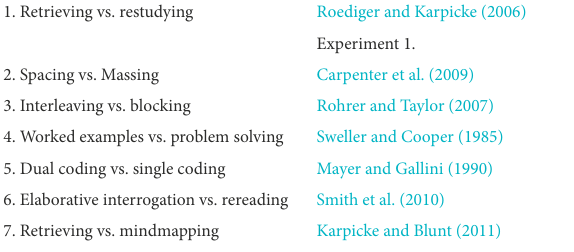
TABLE 3 Seven learning